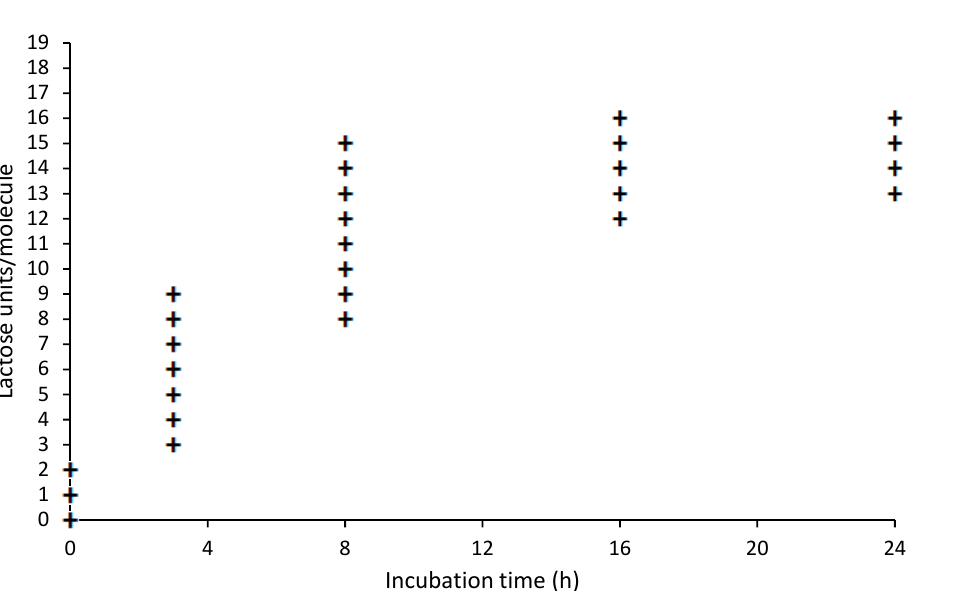
Figure 4. Lactose units (+) per BLG molecule. BLG seems to reach a maximum of 16 lactose moieties per molecule after 16 h. In the initial phase, 0 to 8 h incubation, varying amounts of lactose per protein can be observed.